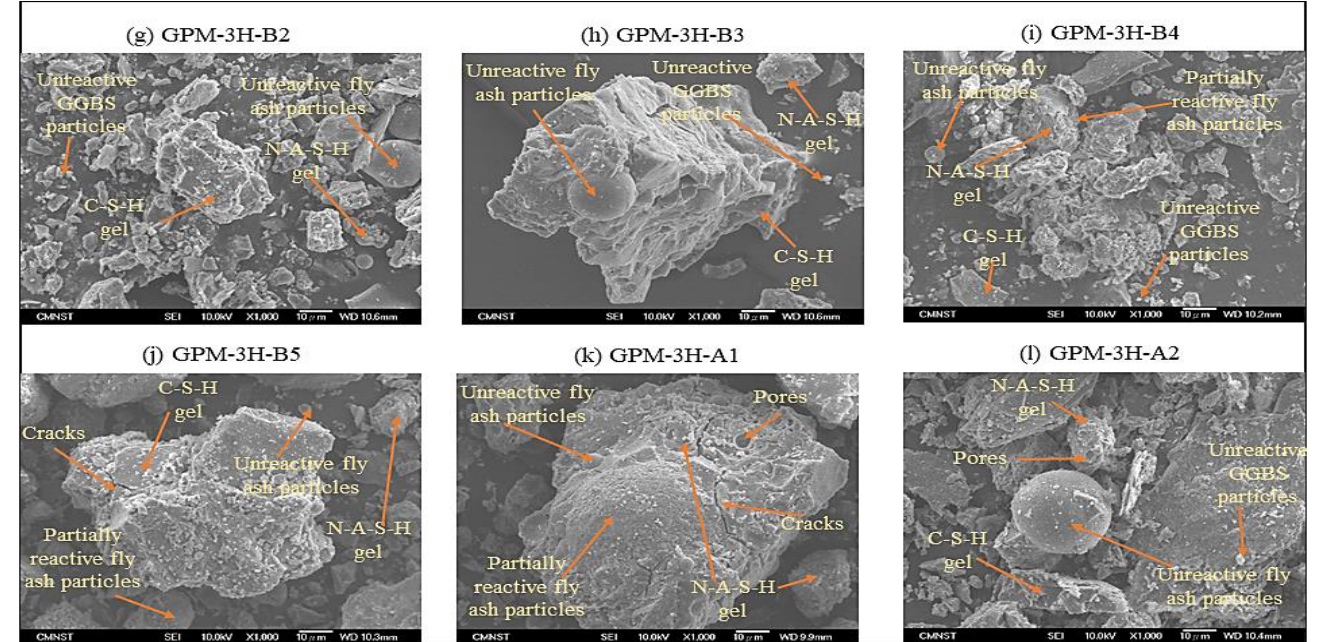
Figure 18. SEM picture of the GPM paste cured in a hot oven at a fixed temperature of 50 °C for 3 h while being exposed to various SS-to-SH and FA-to-GGBS ratios and 1 d room-temperature curing: